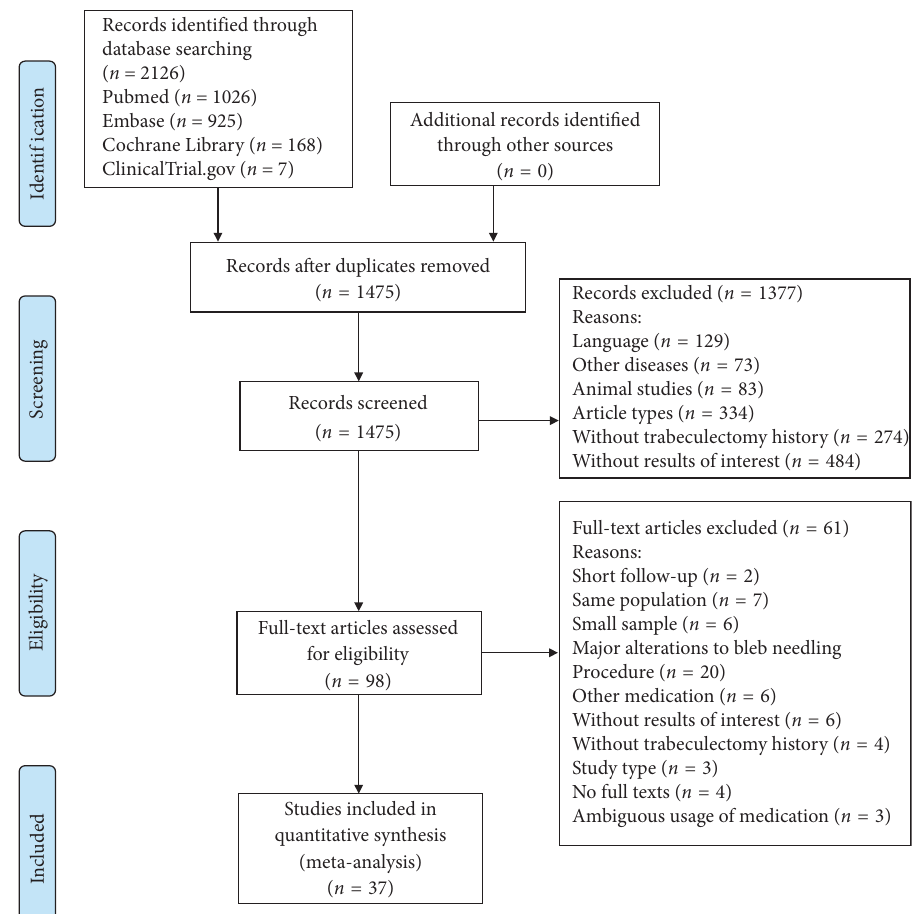
Figure 1: Flow diagram of literature search and included studies for